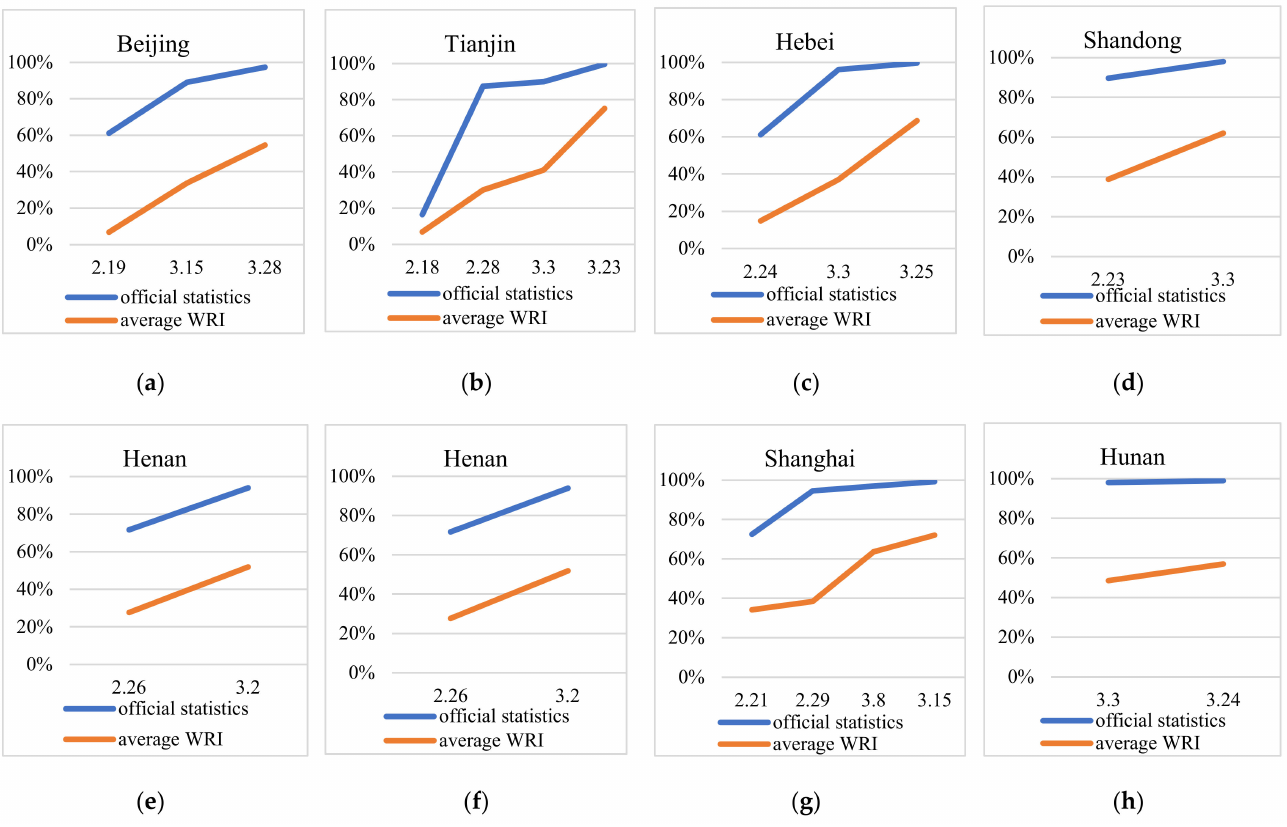
Figure 8. Comparison of work resumption indexes based official statistics and our method in ( a ) Beijing, ( b ) Tianjin, ( c ) Hebei, ( d ) Shandong, ( e ) Henan, ( f ) Jiangsu, ( g ) Shanghai, ( h )